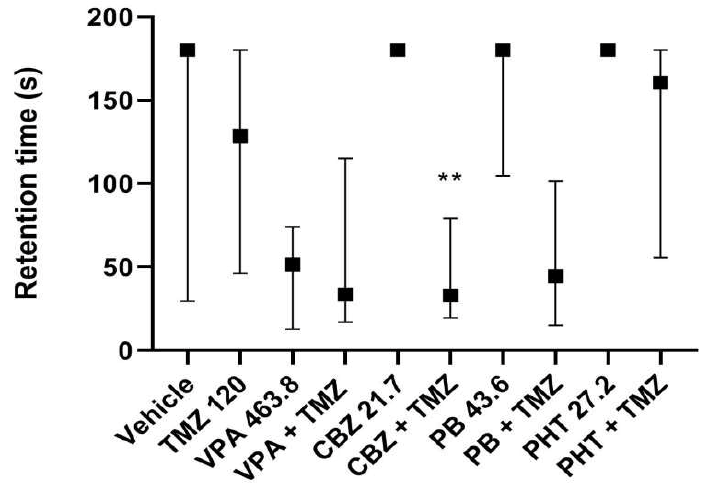
Figure 2. Results are shown as median retention time (with 25th and 75th percentiles) during which mice avoided the dark room in the step-through passive-avoidance task. Drug doses used in this test reflect ED50 doses of combinations of TMZ (120 mg/kg) with the antiepileptic drugs from the MES test. Statistical analysis of data was performed using a nonparametric Kruskal–Wallis ANOVA test followed by Dunn’s post hoc test. TMZ—trimetazidine, VPA—valproate,